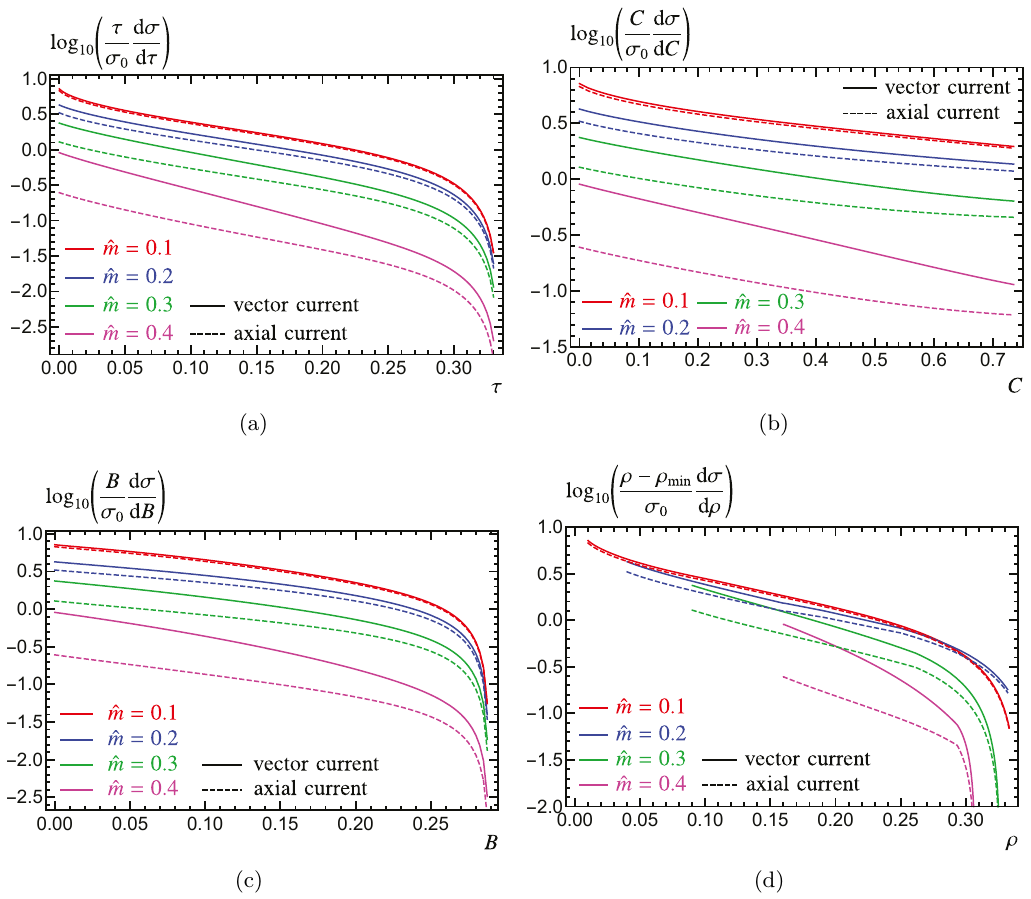
Figure 15 . Event-shape distributions for vector (solid curves) and axial-vector (dashed curves) currents. Panels (a), (b), (c), and (d) show results for thrust, C-parameter, jet broadening, and heavy jet mass, respectively. All curves are multiplied by e (cid:0) e min , with e the event-shape value and e min its minimal value, such that the cross section is (cid:12)nite for e = e min . Red, blue, green and magenta lines show the results for ^ m = 0 : 1 ; 0 : 2 ; 0 : 3 and 0 : 4,